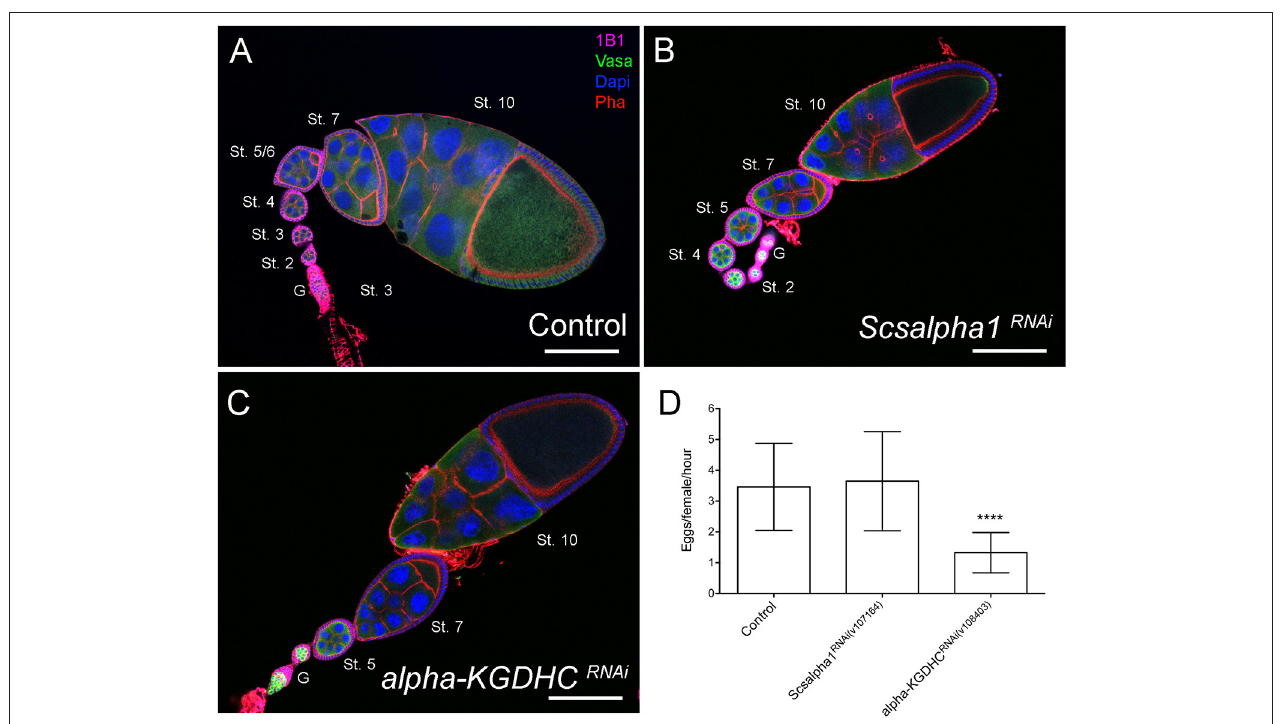
FIGURE 7 | Downregulation of essential TCA cycle enzymes in the germline does not affect egg chamber morphology. (A–C) Representative images of ovarioles of indicated genotypes. Ovarioles of Scsalpha1 RNAi (B) or alpha-KGDHC RNAi (C) show no obvious defects in egg chamber morphology compared with control ( mCherry RNAi ) (A) . Ovarioles of alpha-KGDHC RNAi (C) present a reduced number of developing egg chambers comparing with control (A) or scsalpha1 RNAi (B) . Developmental stages of egg chambers are indicated (St.). Scale bars represent 100 µ m. (D) Quantification of the average number of eggs laid ( ± SD) per hour post-mating, per female of the indicated genotype when crossed to wild-type males. Consistently, females expressing alpha-KGDHC RNAi show decreased fertility. Statistical significance of differences compared with control was calculated using simple sample t -test. **** P <